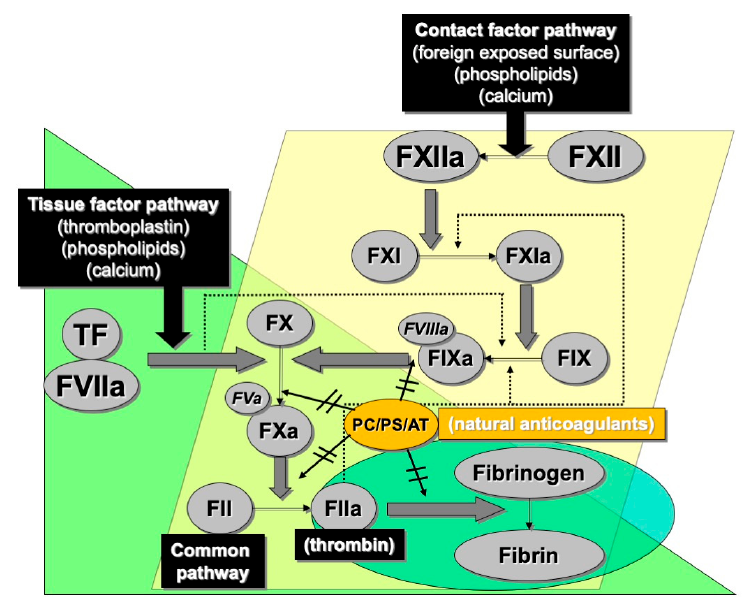
Figure 3. The historical cascade model of hemostasis reflects a series of protease-led activation of subsequent factors in the cascade, and closely reflects the routine laboratory tests we use to broadly assess coagulation. The ‘contact factor pathway’ (also historically known as the intrinsic pathway of coagulation) essentially matches the activated partial thromboplastin time (APTT) test, the ‘tissue factor pathway’ (also historically known as the extrinsic pathway of coagulation) essentially matches the prothrombin time (PT) test. Both converge into a so-called common pathway, which ultimately leads to generation of thrombin (activated factor II), and conversion of the most abundant coagulation plasma protein (soluble) fibrinogen to (insoluble) fibrin. A series of natural anticoagulants (protein C [PC], protein S [PS] and antithrombin [AT] help to control the coagulation process.